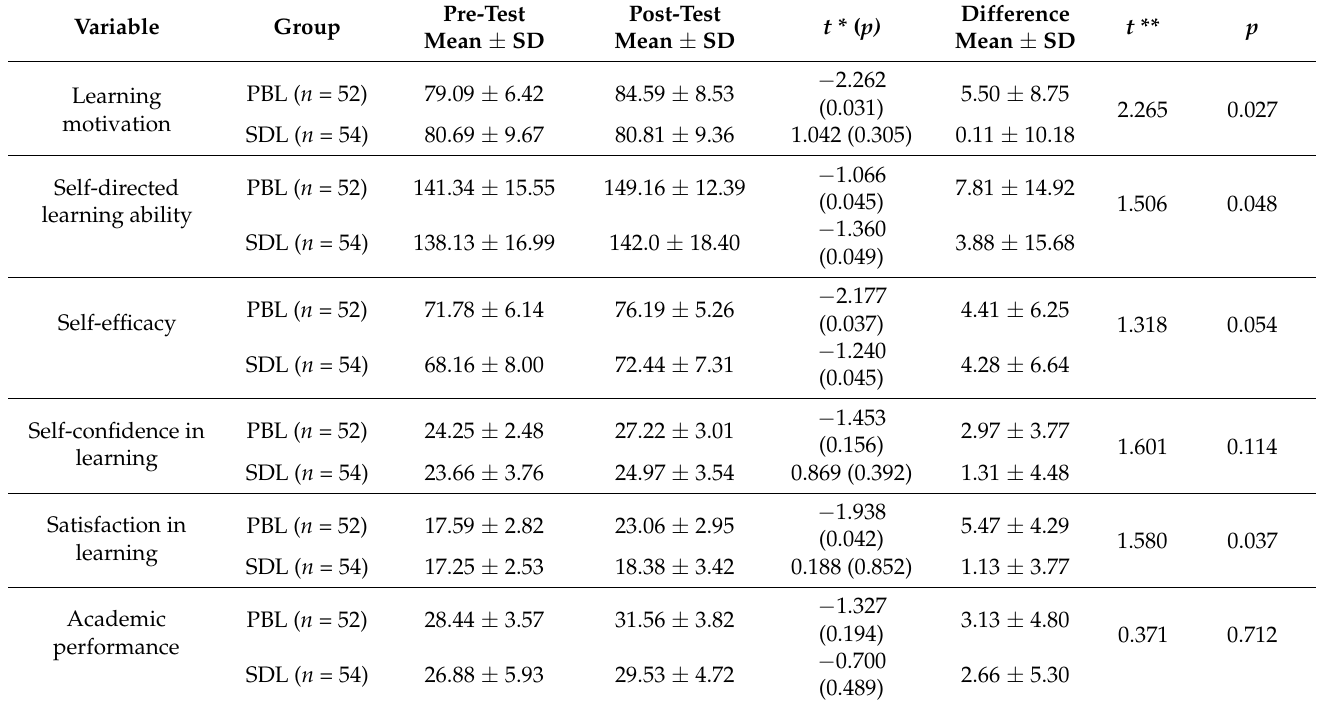
Table 3. Pre-post comparison of study